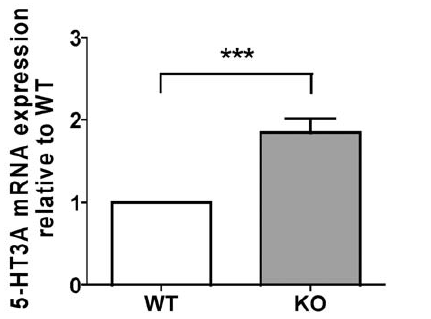
Figure 3. Increase in the expression of 5-HT3a mRNA in the hippocampus of KO mice. mRNA expression of 5-HT3a receptor in KO mice relative to that in WT as determined by RT-PCR. ***p , 0.001.